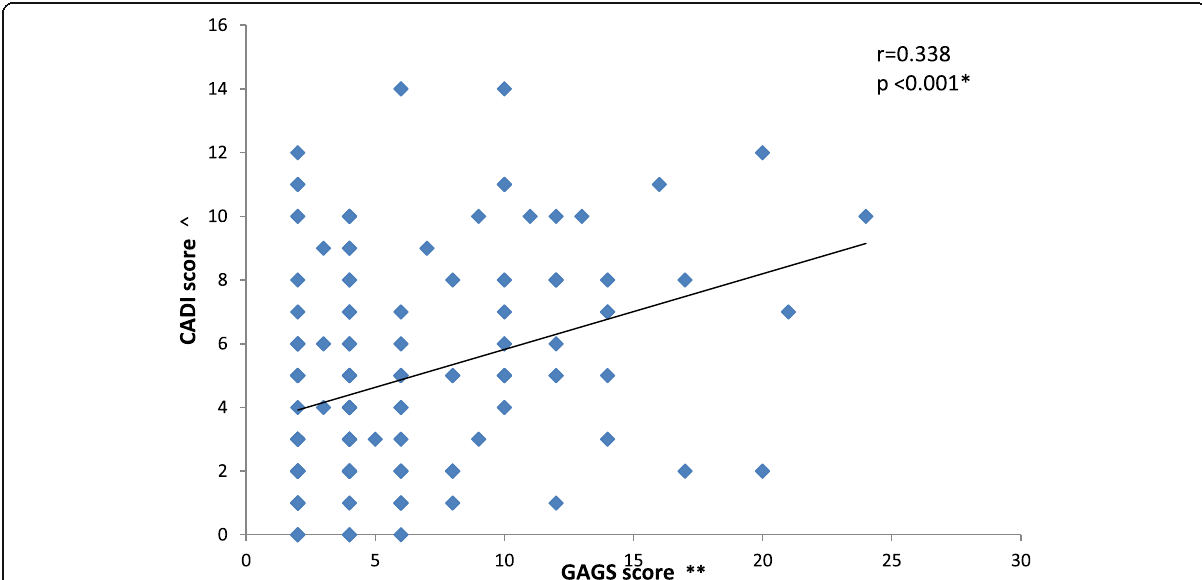
Fig. 1 Pearson ’ s coefficient demonstrating correlation between acne severity (Global Acne Grading Score**) and degree of disability of quality of life (CADI score^). **Global Acne Grading System. ^ Cardiff Acne Disability